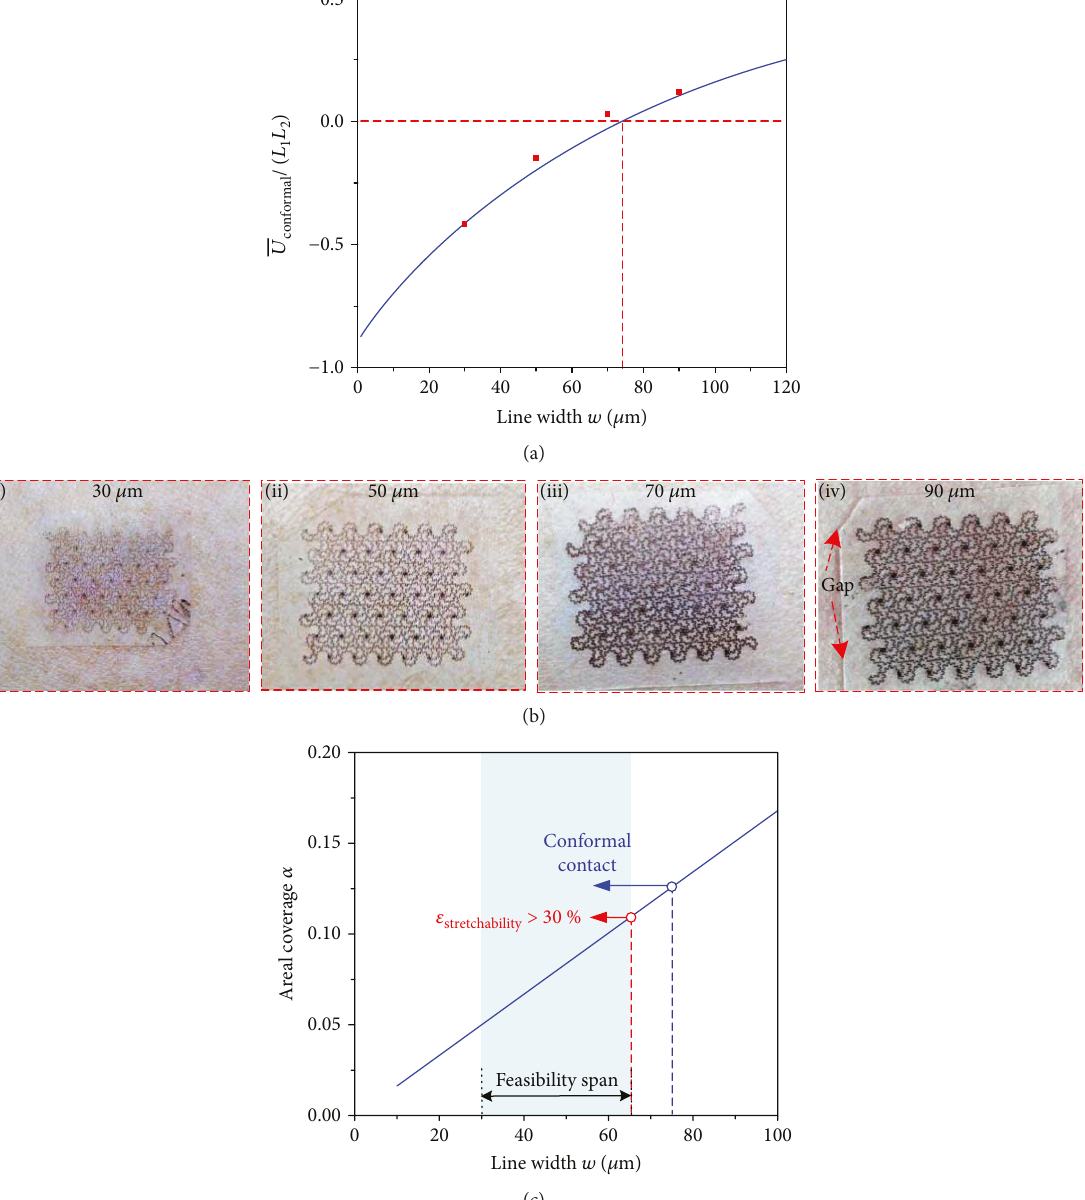
Figure 7: Conformability analysis for the electrodes with di ff erent line widths. (a) Theoretical and experiment results of the network-shaped electrode contact with the skin with di ff erent line widths. (b) Optical images of the electrodes contact with the skin surface (I) 30 μ m; (II) 50 μ m; (III) 70 μ m; and (IV) 90 μ m. (c) Feasible range of the line width of the electrode with given stretchability and